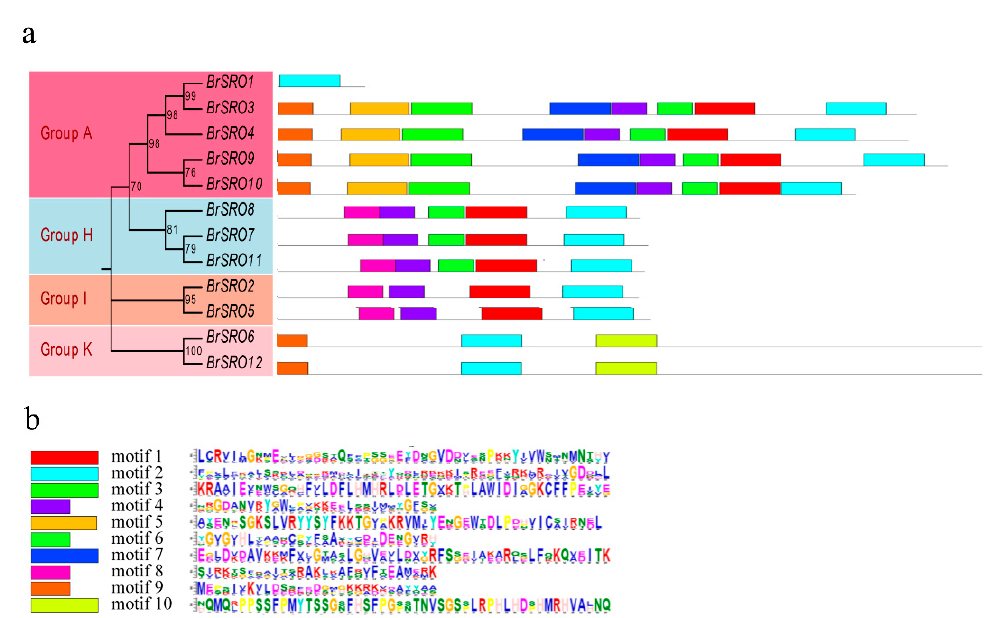
Figure 4. The conserved motifs of the BrSRO proteins based on the phylogenetic relationship. The BrSRO proteins phylogenetic relationship ( a ). The BrSRO proteins annotated with the MEME server ( b ). Distribution of the BrSRO conserved motifs in Chinese cabbage was analyzed by the online tool MEME. Ten motifs are marked by different colors.